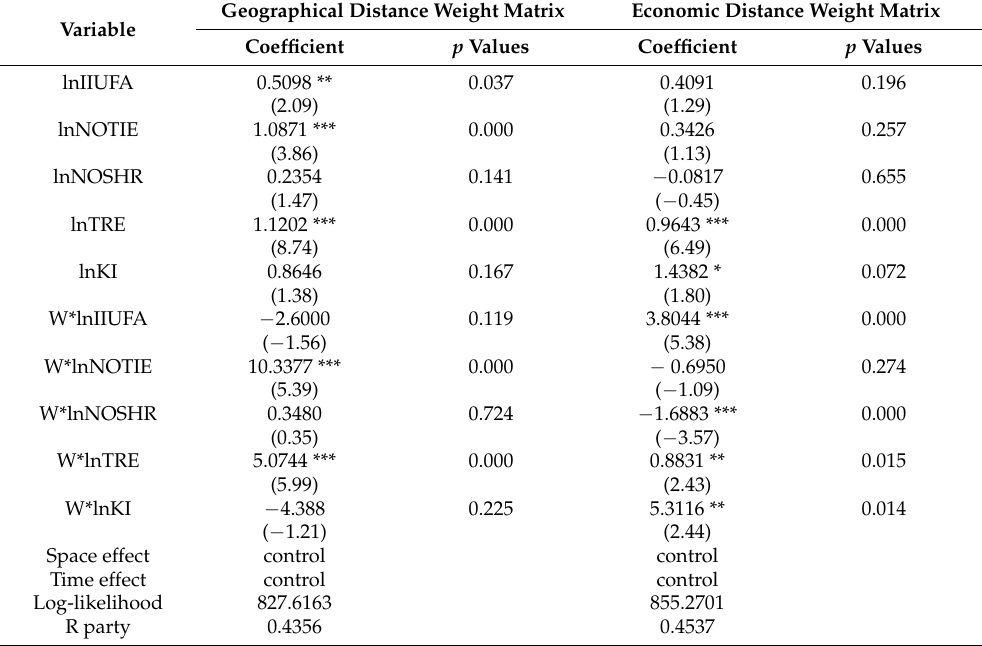
Table 4. Estimation results of spatial panel Dubin model.